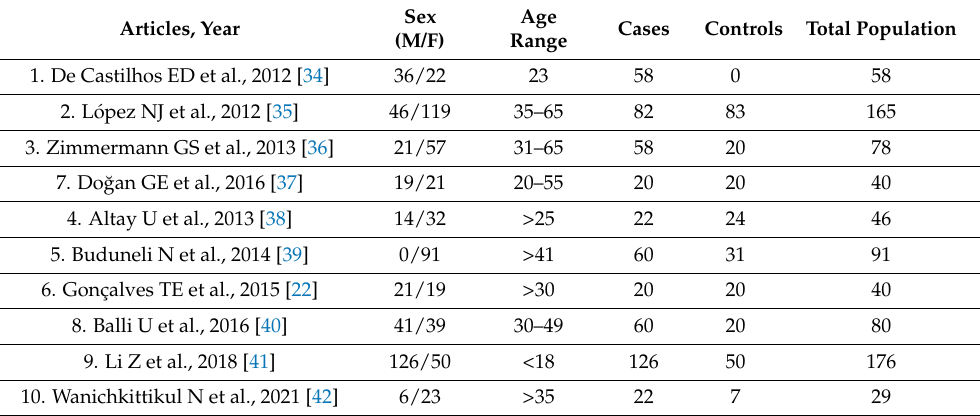
Table 3. Demographic Characteristics of the Patients.